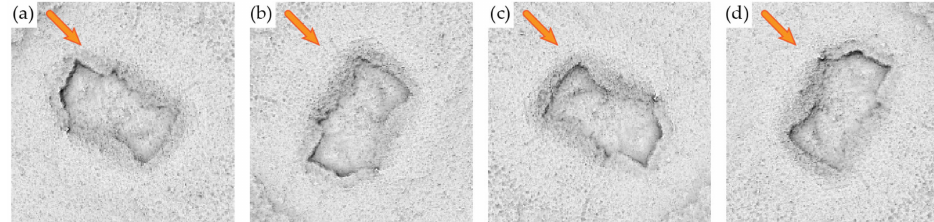
Figure 9. Image samples of original aguada ( a ) and rotated aguadas ( b ) by 90 ◦ , ( c ) by 180 ◦ and ( d ) by 270 ◦ . The rotated image samples have shadows that are cast in the same direction (315 ◦ azimuth, orange arrows) as that of the original.